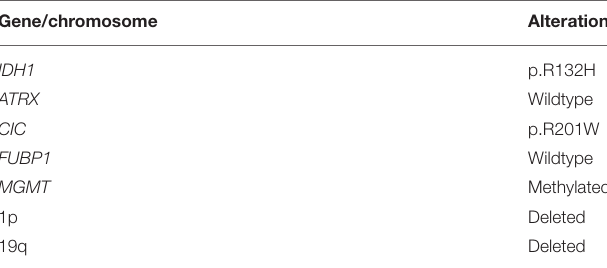
TABLE 1 | Summary of genetic